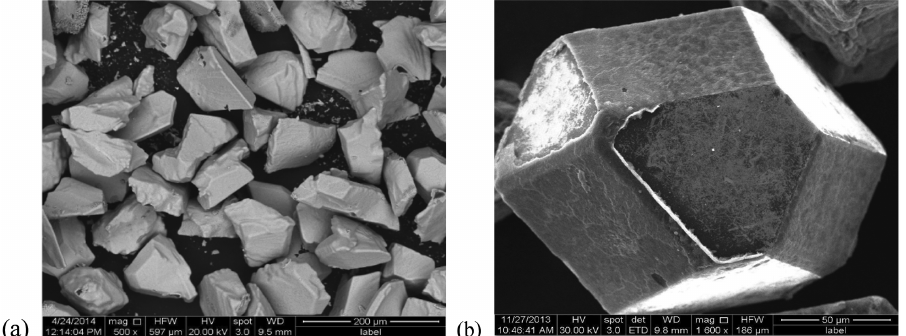
Figure 7: The SEM images of coated diamond by (a) microwave heating and (b) conventional heating at temperature of 850 ° C for